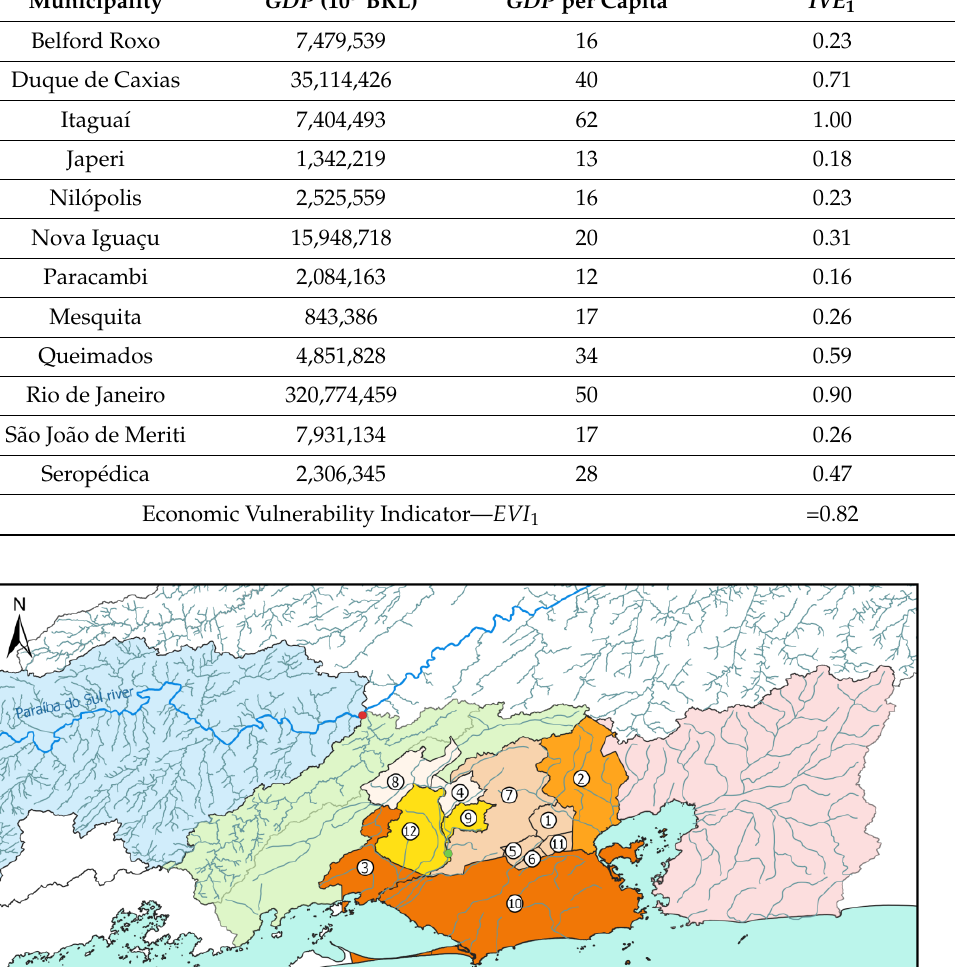
Table 17. Economic vulnerability indicator ( EVI 1 ) determination.